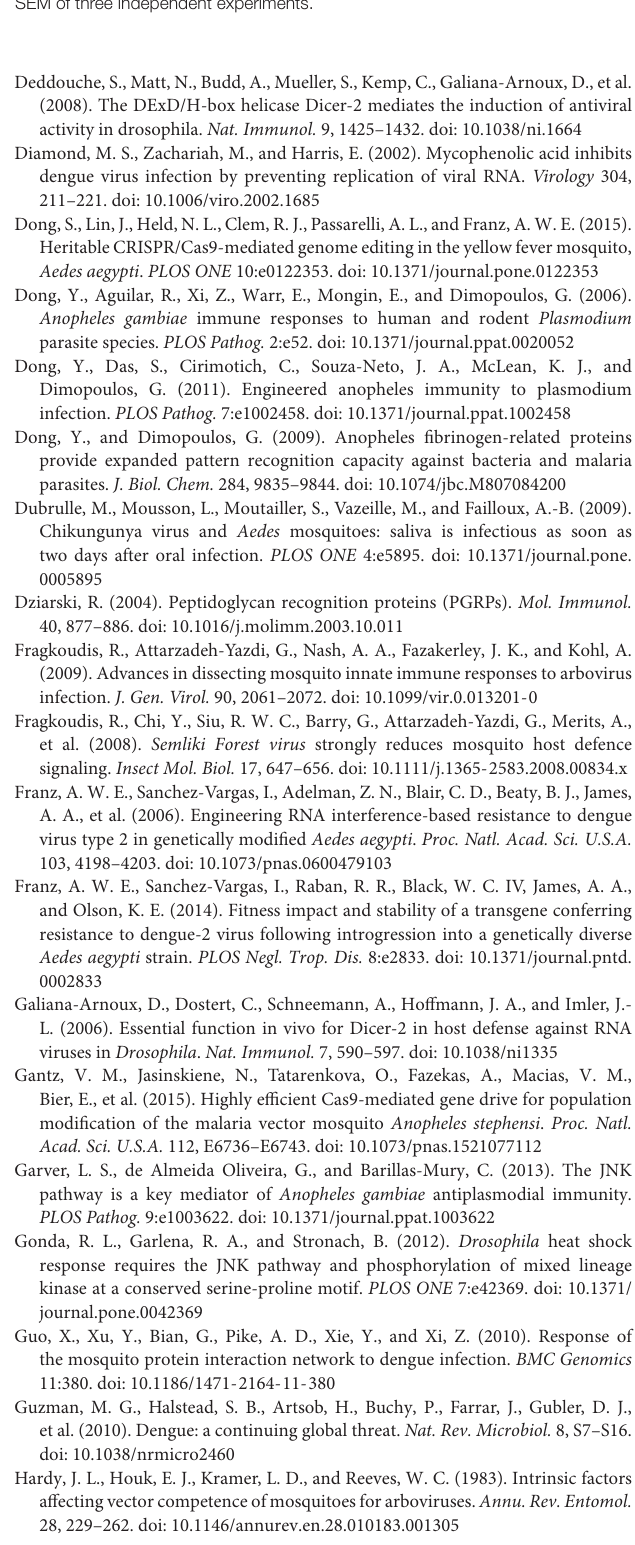
FIGURE S2 | Silencing efficiency. qRT-PCR of silenced genes cactus (Toll), caspar (Imd), and PIAS (Jak/Stat). (A) Immune genes. (B) Host factors. Bars represent SEM of three independent